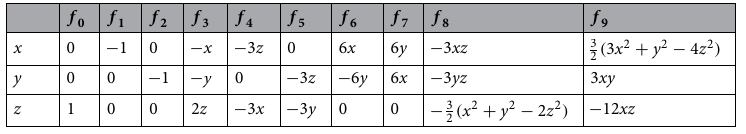
Table 1. Table of the x , y and z components of the basis vector function f n up to order n = 9 .